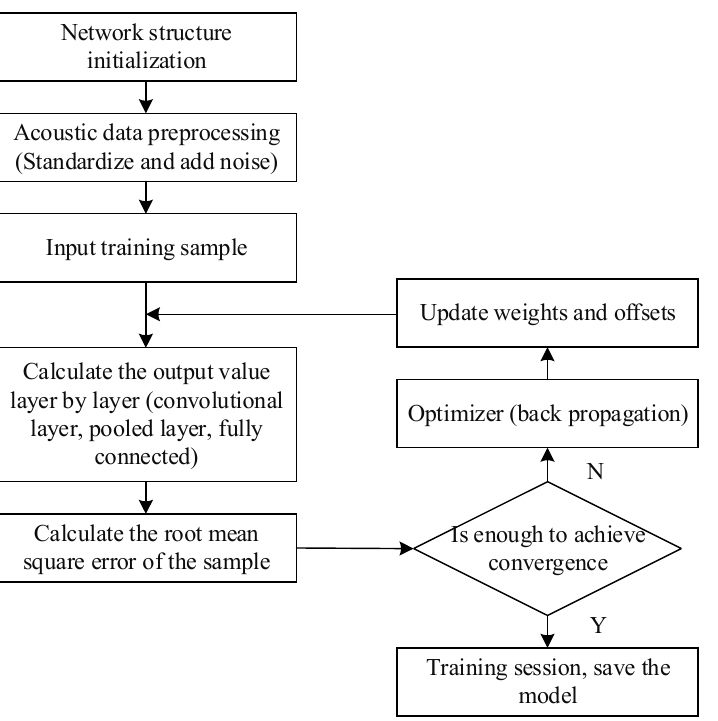
Figure 2. Based on CNN velocity inversion process.